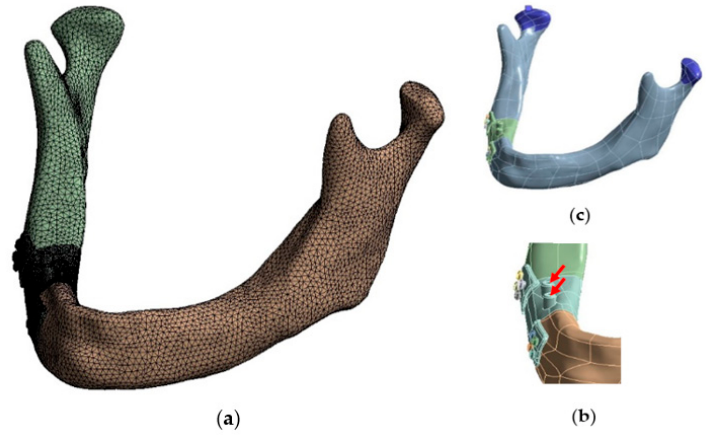
Figure 4. ( a ) FE model of Model 1. ( b ) The temporomandibular joint is the region specified by the boundary conditions (blue area). ( c ) Oblique occlusal force (100 N) was applied above the abutment (the red arrow).